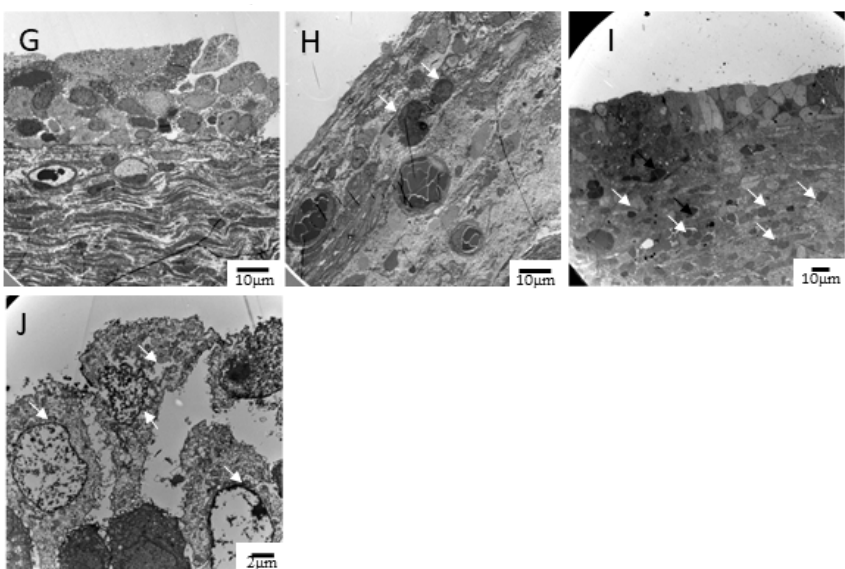
Figure 1. Representative figures of bladder ultrastructural defects in EM. ( A ) Normal, ( B ) mild defect, and ( C ) severe defect of the urothelial layers. ( D ) Normal, ( E ) mild defect, and ( F ) severe defect of the tight junction in the surface of urothelial cells. ( G ) Normal, ( H ) mild, and ( I ) severe infiltration of inflammatory cells (white arrow) in the lamina propria of the bladder. ( J ) Epithelial cells with lysed organelles and nucleus.